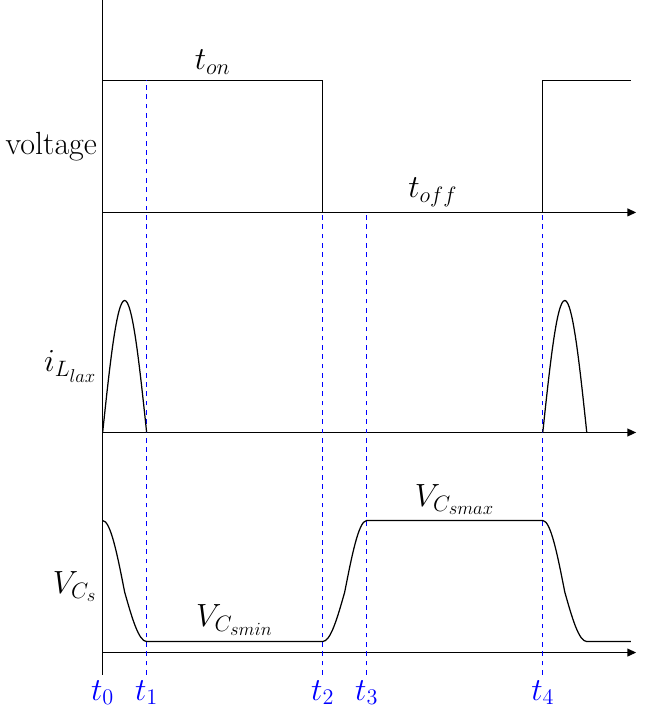
Figure 4. Waveforms for gate voltage, V C